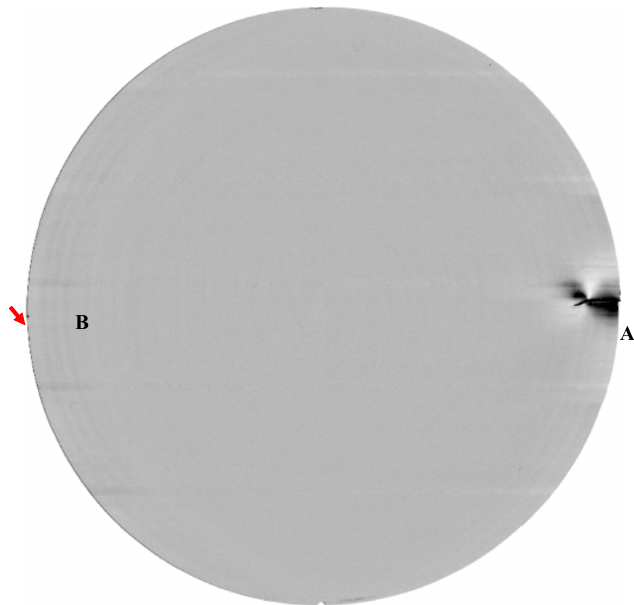
Figure 10. X-ray diffraction image, taken on a prototype of the Bruker/Jordan Valley QCTT wafer imaging tool, of two edge indents, one ( A ) of which generated a macroscopic crack in the 200 mm diameter wafer ( right ) and one ( B , arrowed) which did not nucleate such a crack ( left ).